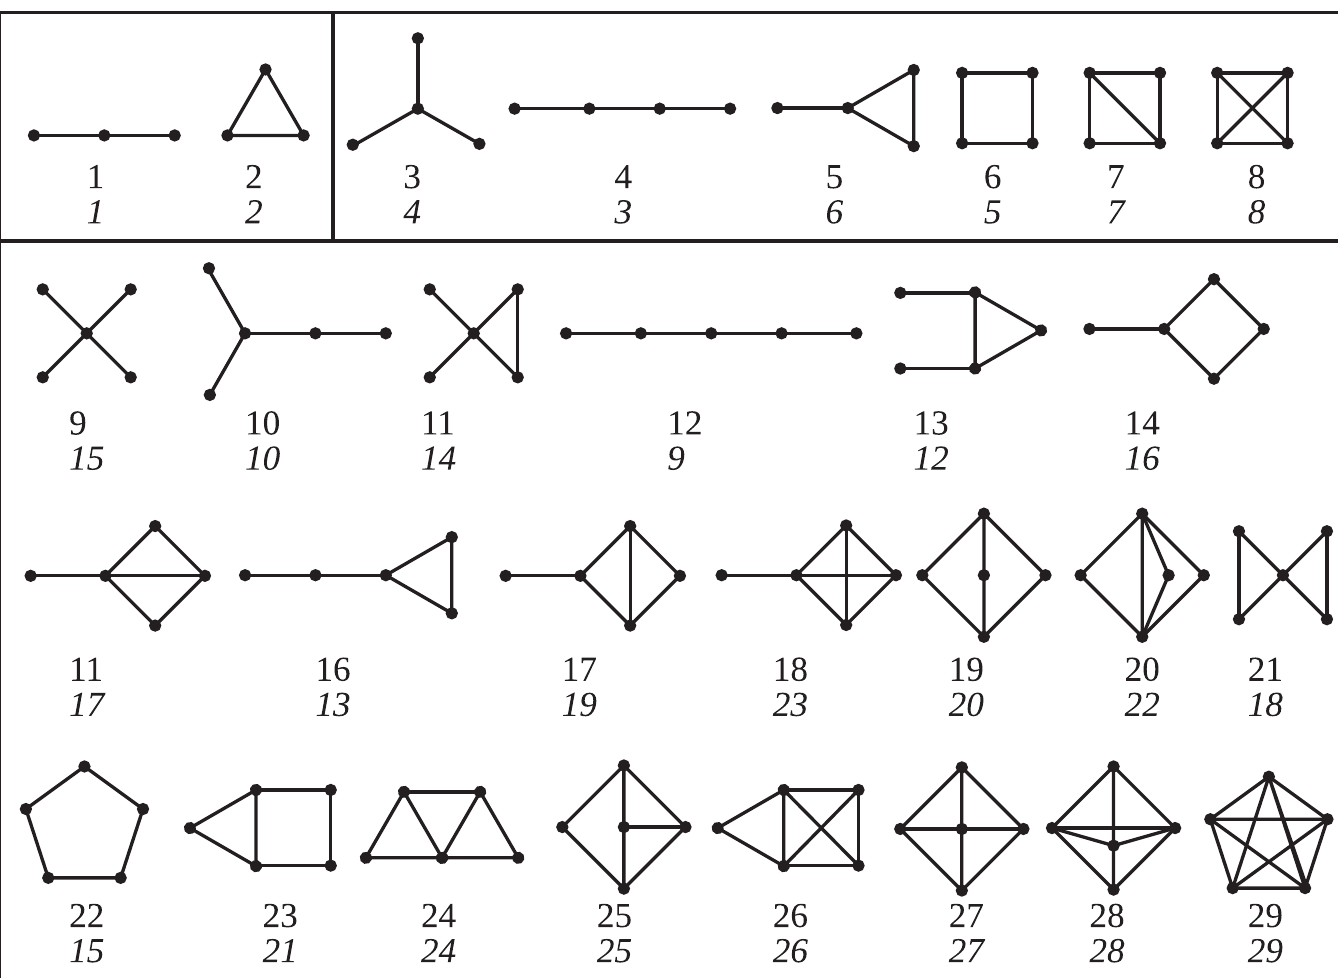
Fig 13. All graphlets up to order 5. The numbers in normal font are the graphlet ordering generated by the algorithm, the numbers in italic font are Pr ž ulj ’ s